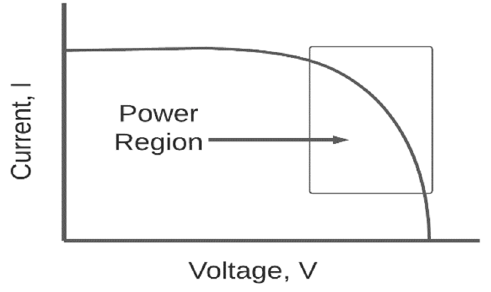
Figure 2. The current-voltage (I–V) characteristics of a typical PV panel/array operating under normal conditions.